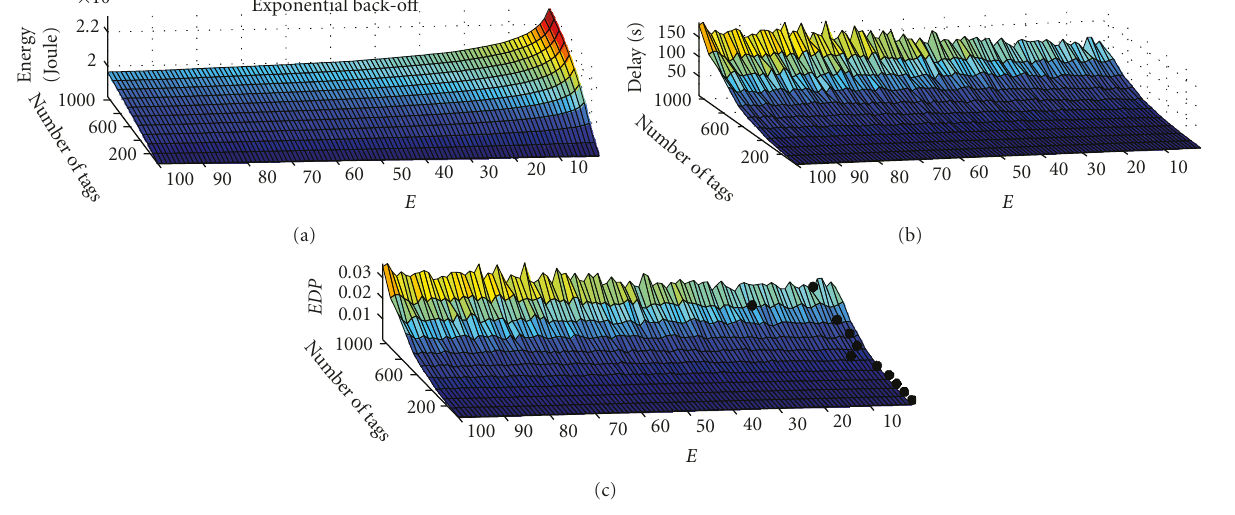
Figure 12: Exponential back-o ff algorithm.